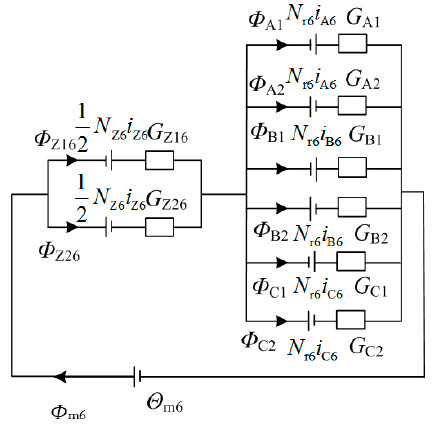
Figure 8. The equivalent flux circuit of six ‐ pole radial ‐ axial hybrid magnetic bearings (HMB). According to Gauss’s law the expression of fluxes in axial and radial air gaps can be obtained: